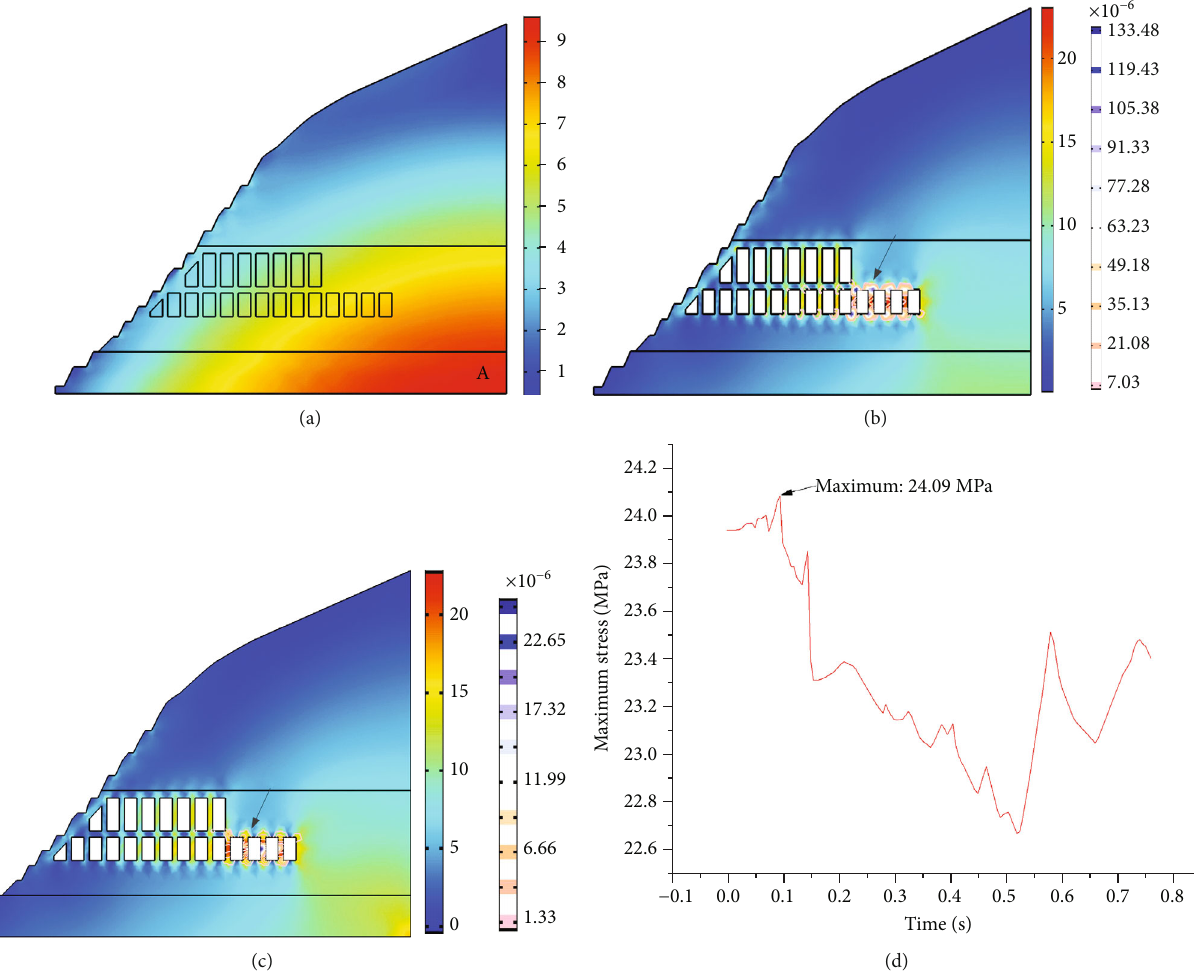
Figure 6: von Mises stress for 3 research steps; (a) before the exploitation of hanging-wall ore; (b) after the exploitation of hanging-wall ore; (c) after open-pit blasting; and (d) maximum stress value ’ s changing law within the slope along with the blasting